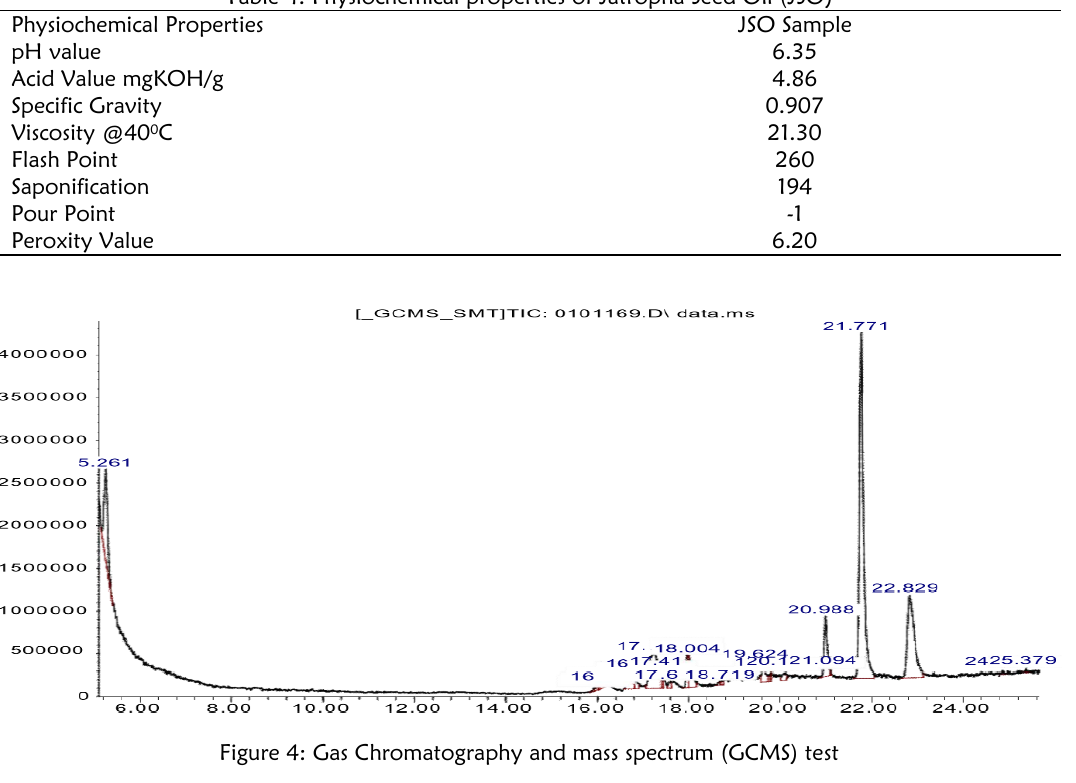
Figure 4: Gas Chromatography and mass spectrum (GCMS) test